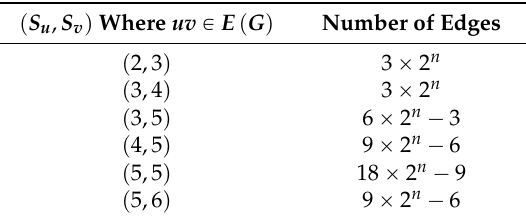
Table 1. Edge partition of PAMAM dendrimer, PD 1 r n s based on degree sum of neighbors of end vertices of each